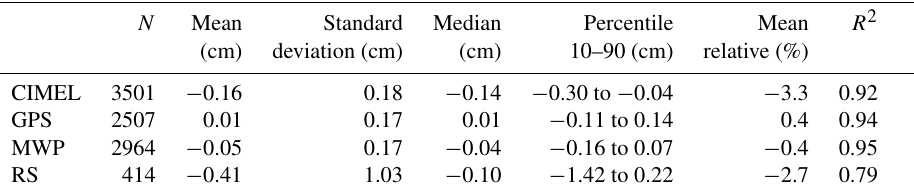
Table 1. Statistics of differences among retrievals from PSR using monochromatic approach at 946nm and retrievals from other instruments for the whole data set.